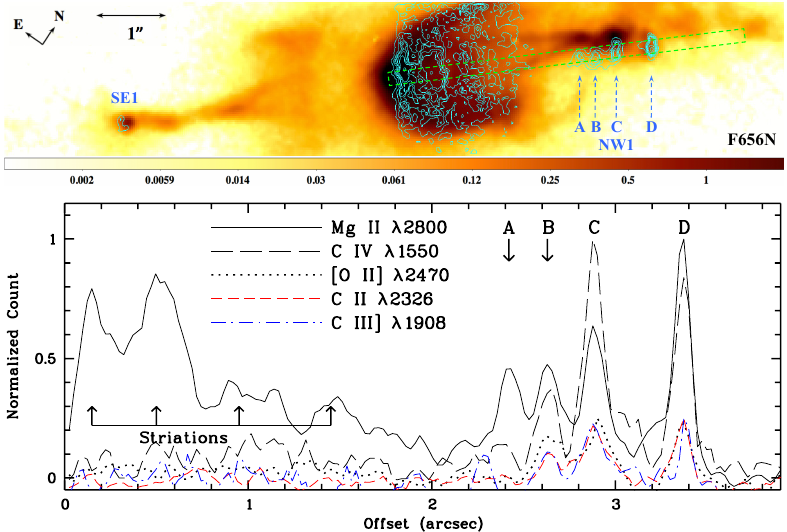
Figure 2. ( Top ) Emission contours (in cyan) of the STIS Mg II λ 2800 line overlaid on the 2009 WFC3 F656N image showing the central 2 (cid:48)(cid:48) × 10 (cid:48)(cid:48) region of Hen3-1475; images are displayed in logarithm and data counts are indicated on the colorbar. The NW1 knot is resolved into four components (A, B, C, and D labeled in blue) in Mg II emission. Nebular core is saturated in F656N to enhance lobe structures, including NW1/SE1 and the conical shocks. ( Bottom ) Emission profiles of different UV nebular lines along a cut (green-dashed rectangle in the top panel) through the central star and the NW1 knot components, at PA = 311 ◦ ; positions of the four components of NW1 and the striations seen in Mg II emission (Figure 1d) are labeled. The other UV emission lines are shown in Figure